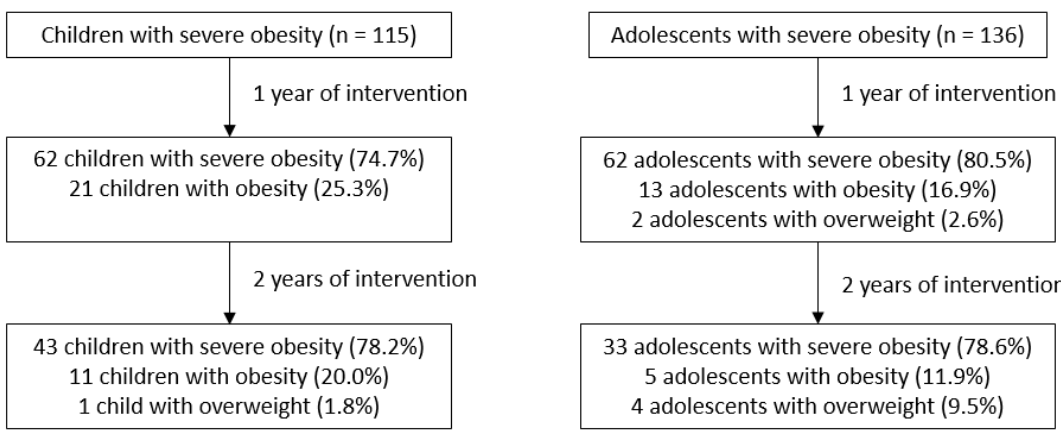
Figure 2. Decrease in BMI z-score after one and two years of intervention in children and adolescents determined by a marginal model for repeated measures (including group, time, and their interaction). Data presented as estimated marginal means and standard error. * p value ≤ 0.05, statistically different between children and adolescents.